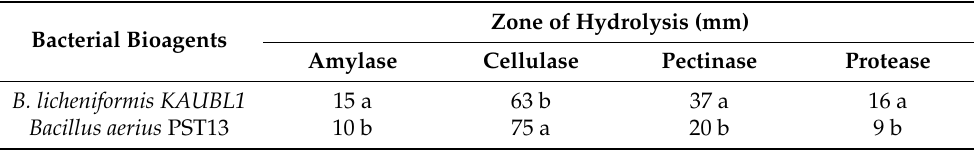
Table 3. Extracellular enzymatic activities of Bacillus licheniformis and B. aerius .